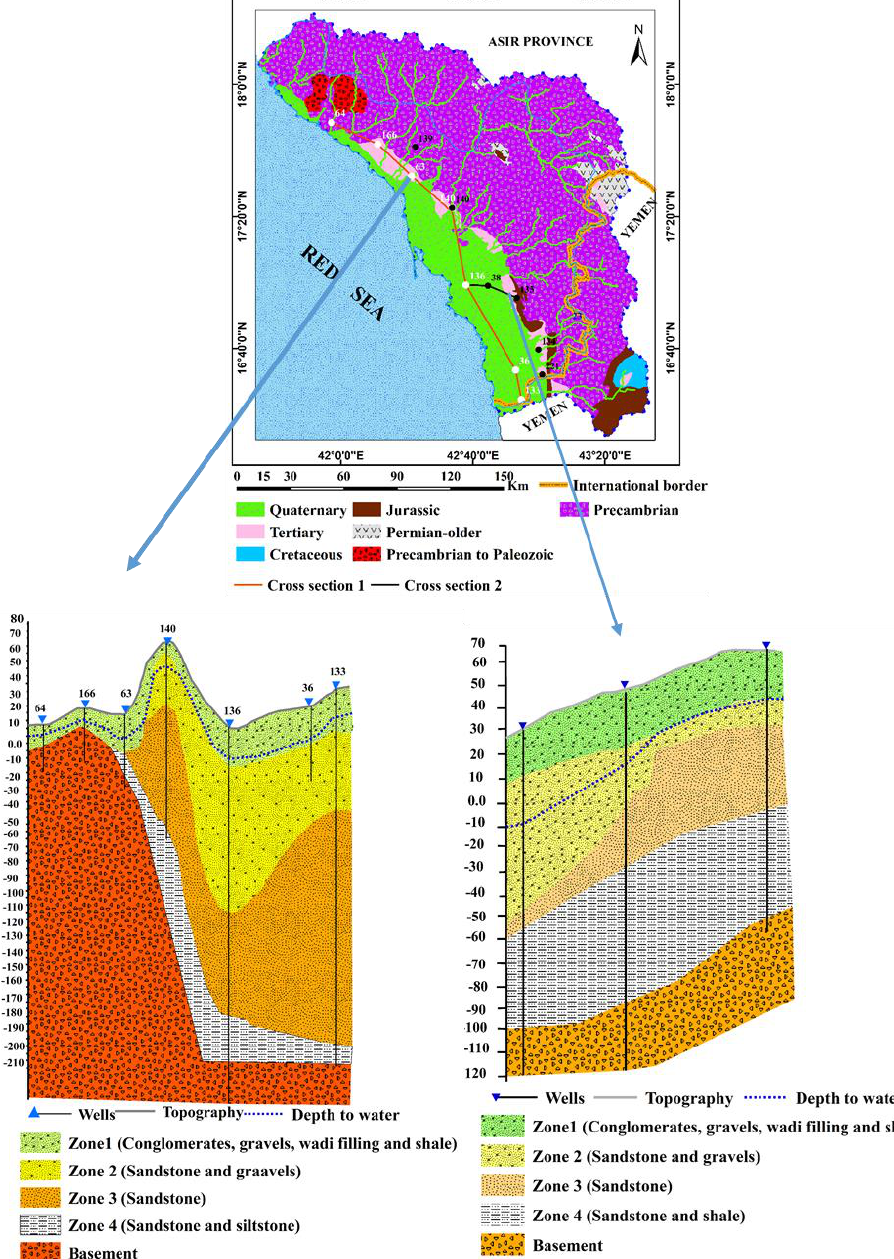
Figure 3. Hydrogeological cross-sections of the study area (unconfined aquifer).